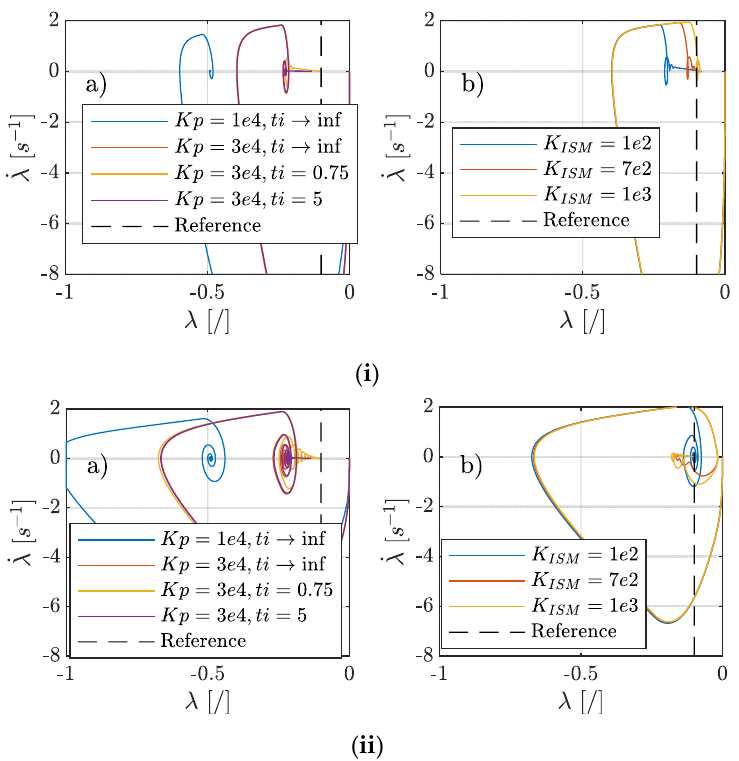
Figure 7. Phase plane trajectory for emergency braking on wet surface with ( i ) IWMs and ( ii ) friction brakes with respect to varying gains for ( a ) PI and ( b ) ISM control.